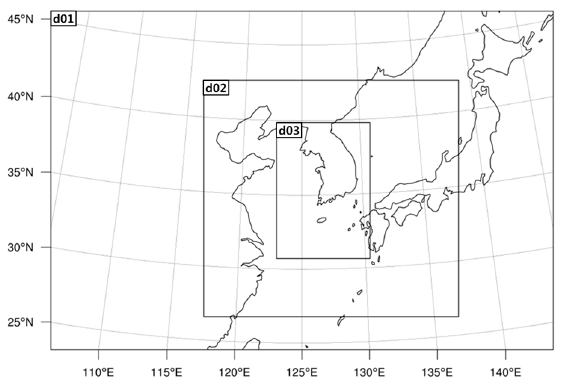
Figure 2. Domain configuration.